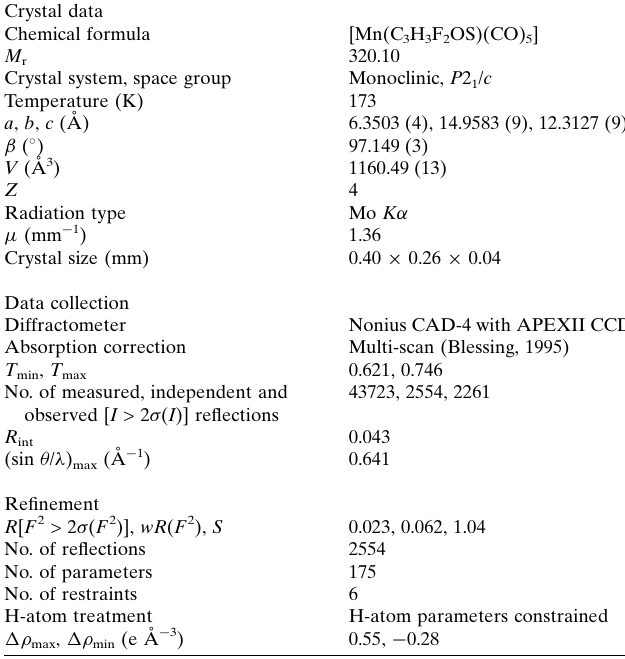
Table 3 Comparison of selected bond lengths (A˚ ) and bond angle ( (cid:4) ) in the title compound (1) and related compounds having an Mn(CO) 5 SC